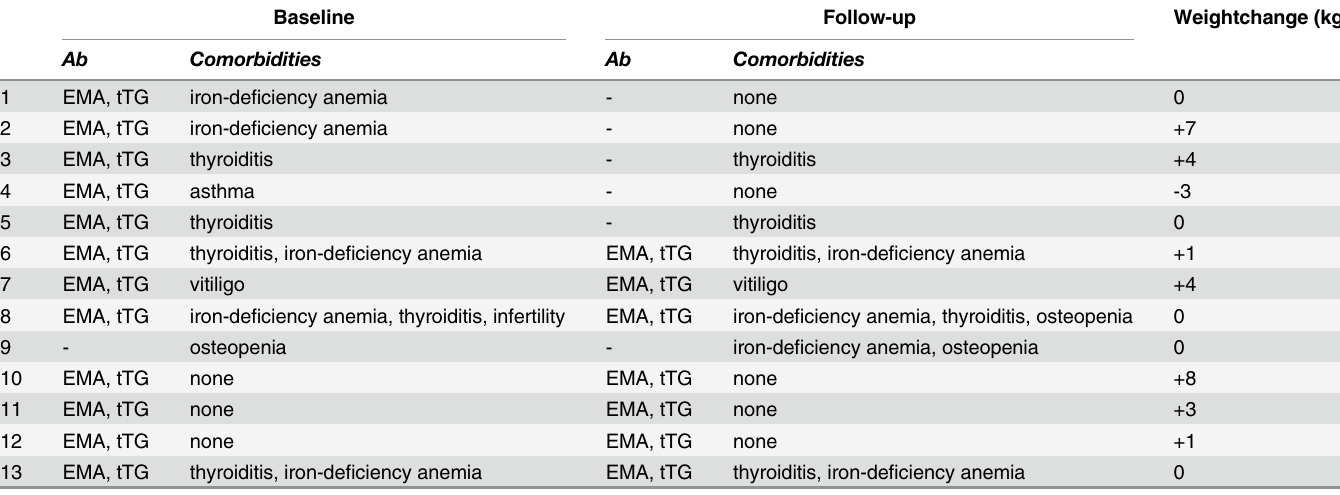
Table 1. Clinical-serological features of CD-patients before and after the gluten-free